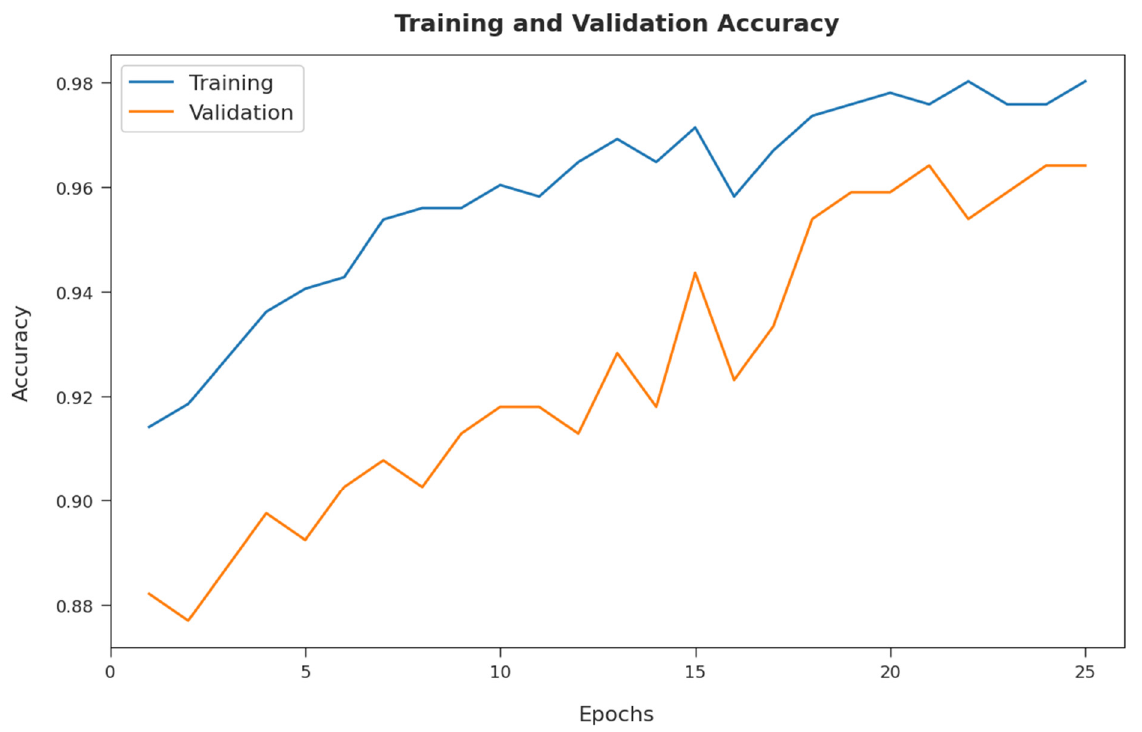
Figure 7. Accuracy graph analysis of FSSML-EDM technique.